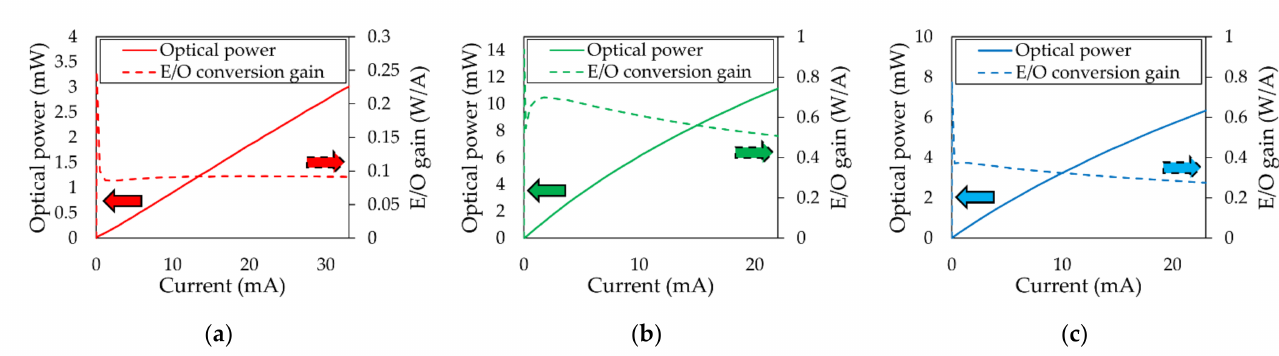
Figure 3. Emission spectra of the ( a ) red, ( b ) green, and ( c ) blue LEDs.